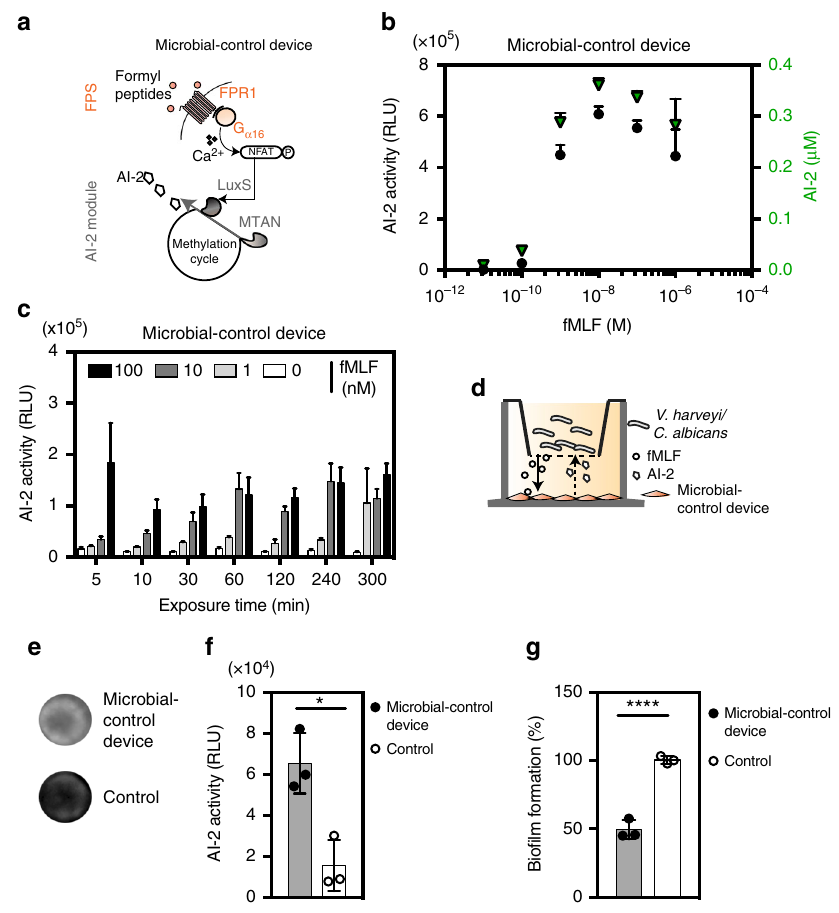
Fig. 5 Validation of the fMLF-responsive microbial-control device. a Illustration of tunable AI-2 release from the microbial-control device. b Microbial- control-transgenic pFS98/pFS102/pFS84/pFS186-cotransfected HEK-293 cells were grown for 24 h in cell culture medium adjusted to increasing fMLF levels, before AI-2 activities were pro fi led (black) and AI-2 concentrations were determined (green) in the culture supernatant. c Impact of fMLF doses and induction time on microbial-control-mediated AI-2 secretion. AI-2 release pro fi le from microbial-control cells exposed to rising fMLF levels and induction pulses after 24 h. AI-2 activity was measured in terms of V. harveyi (MM32) bioluminescence. d Autonomous control of microbial pathogens through microbial-control-engineered cells. Schematic depicts the release of formyl peptides from microbes. Diffusible formyl peptides activate microbial-control cells to release AI-2, which, in turn, induces bacterial bioluminescence or reduces bio fi lm formation. e , f Microbial-control or mock-engineered HEK-293 cells (Control) were seeded in the lower chamber of a Transwell, and then co-cultivated with V. harveyi AI-2 reporter strain (MM32, luxS - ) in the upper compartment. Twenty hours after incubation with mammalian cells, V. harveyi bioluminescence was e imaged and f quanti fi ed. g HEK-293 co-transfected with the microbial-control device components or transfected with pcDNA3.1 (Control) were grown in the bottom chamber and then challenged with C. albicans in the upper compartment. After co-cultivation for 24 h, C. albicans bio fi lm formation was measured by means of MTT assay. Bio fi lm formation is expressed as a percentage of the control value of C. albicans co-cultivated with HEK-293 control cells lacking the genetic components. Data represent the means ± SD of three independent experiments measured in triplicate. * p < 0.05, **** p < 0.00001, two-tailed Student ’ s t